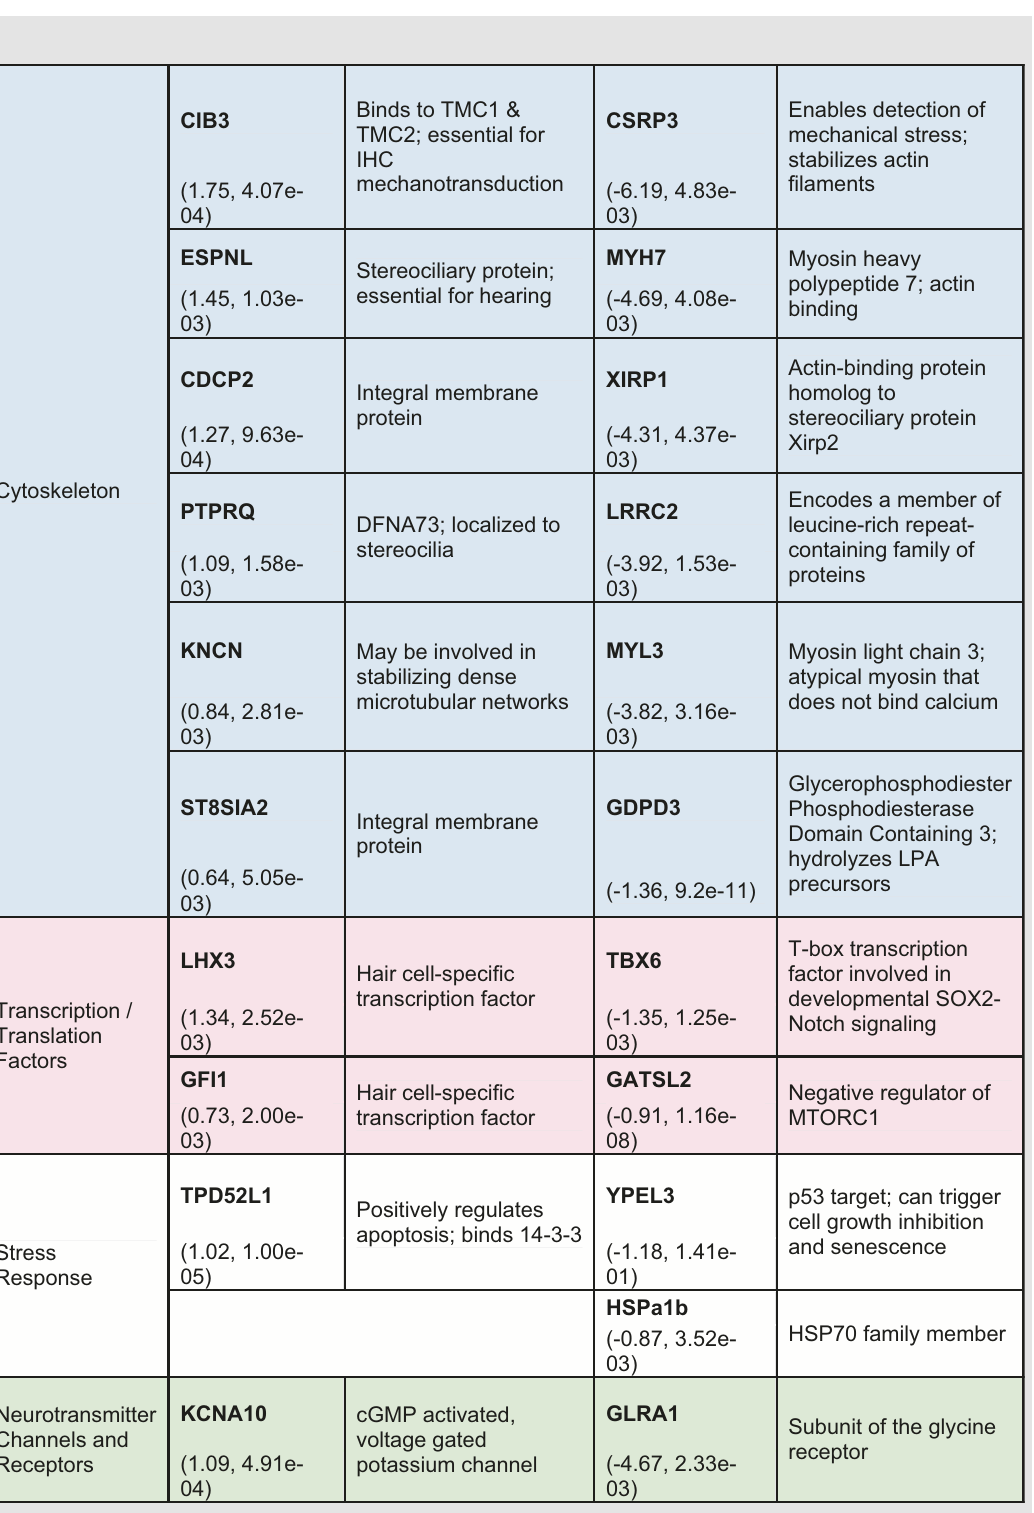
Table 1. Curated changes in genes expressed OHCs at